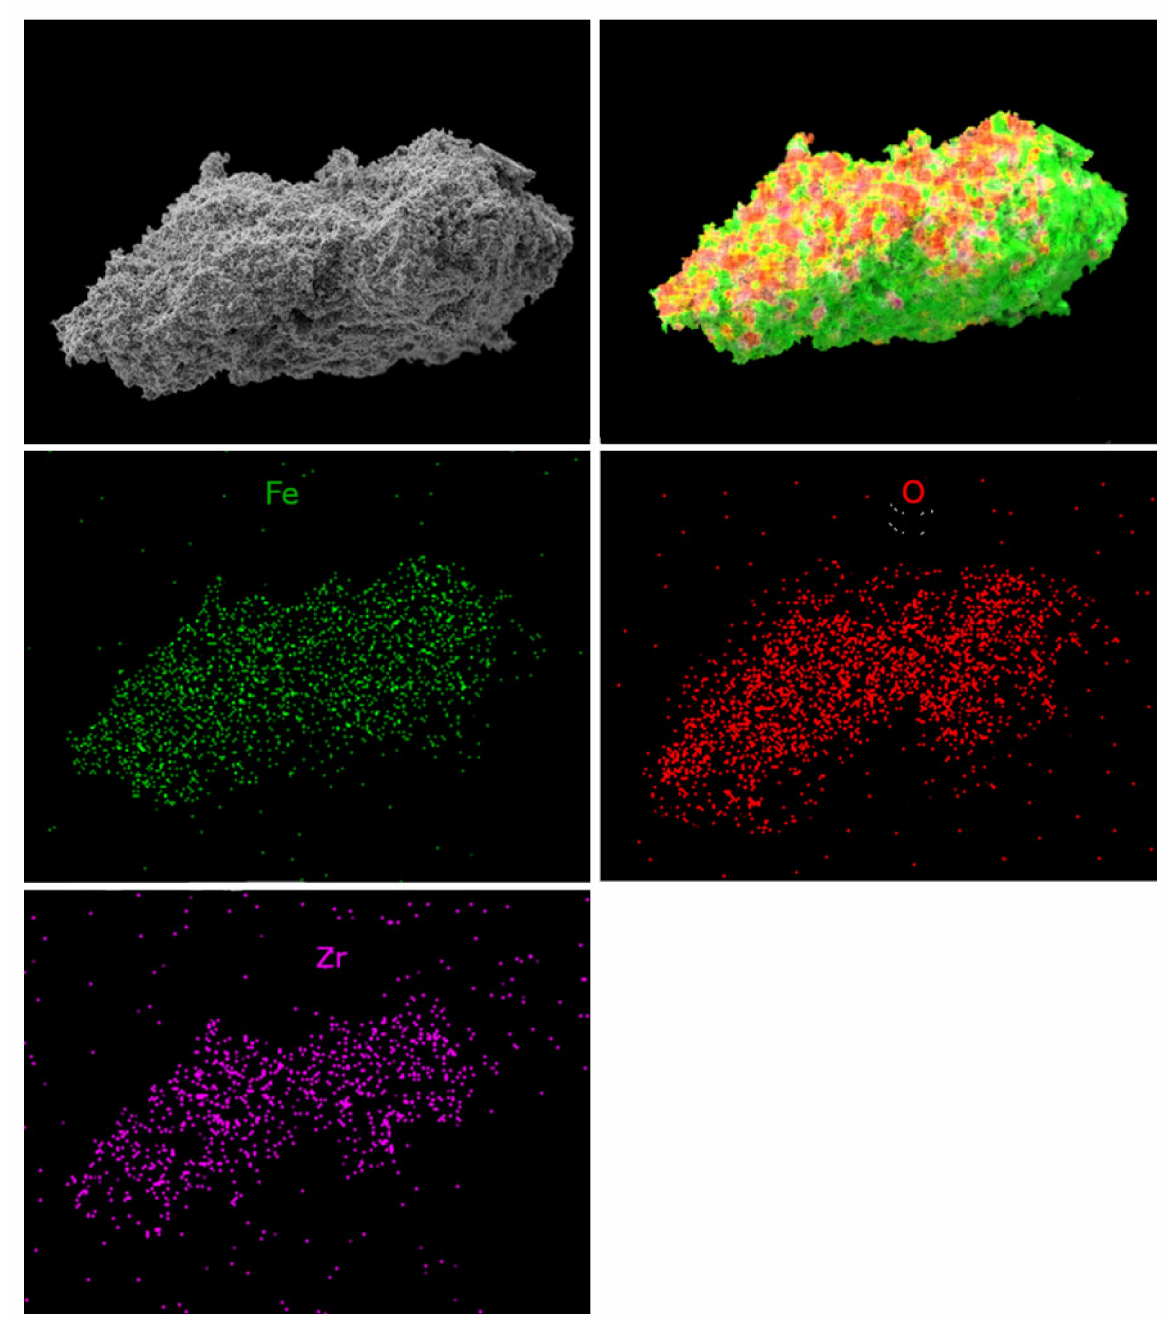
Figure 10. Scanning electron microscope photomicrographs with element mapping for fresh F80Zr20